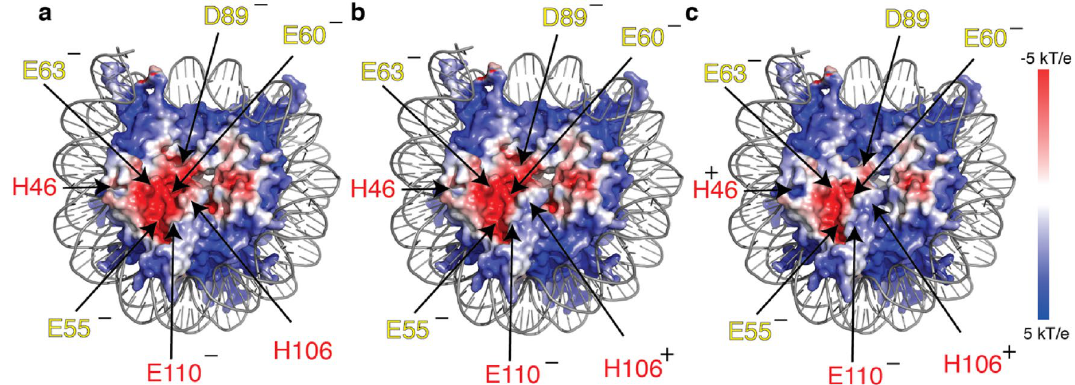
Figure 6. Effect of H2B H106, H46 and H2A D89 protonation on acidic patch electronegativity. Calculated electrostatic surface potentials reflecting different protonation states of residues in the acidic patch. In ( a ) all titratable residues are assigned to their dominant protonation state at pH 7.4, according to measured pKa values in Table 1. In ( b ), H2B H106 is protonated (positive charge), which is protonated for 12% at pH 7.4. In ( c ), H2B H106 and H46 (positive) and H2A D89 (neutral) are protonated, reflecting the least electronegative state at slightly acidic pH (pH 6). Location of key acidic patch residues indicated together with their net charge, yellow = H2A; red =